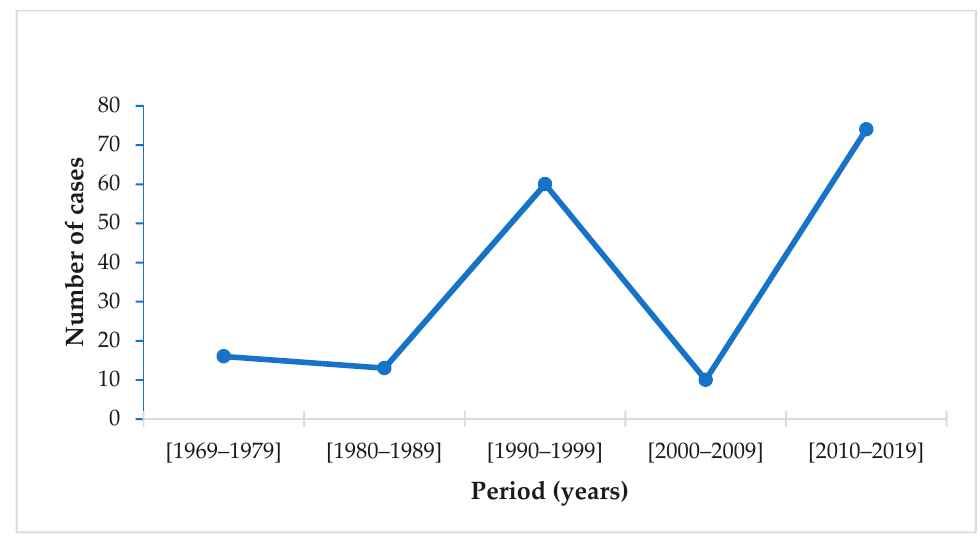
Figure 4. Airport malaria in the European Union: number of cases from 1969 to 2020 per 10-year period [9,25,26,28,86].